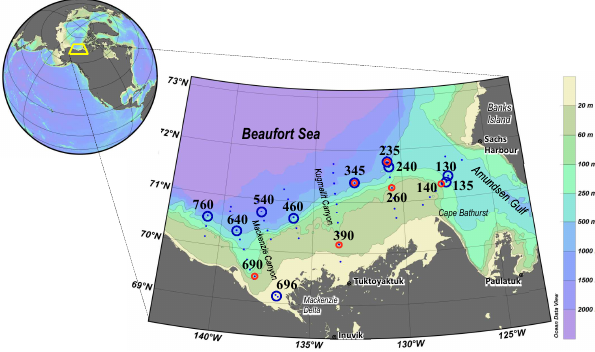
Fig. 1. Map of the Malina survey area. Sites of suspended particu- late matter sampling: blue circles. Sites of sediment sampling: red